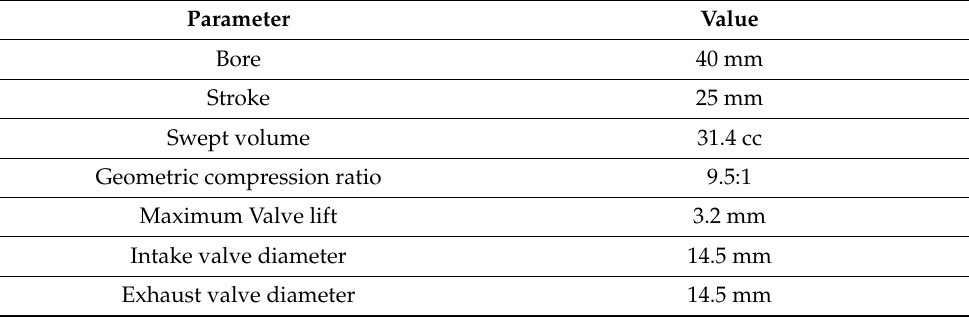
Table 1. The engine specifications of the 31-cc version of the Stihl 4MIX